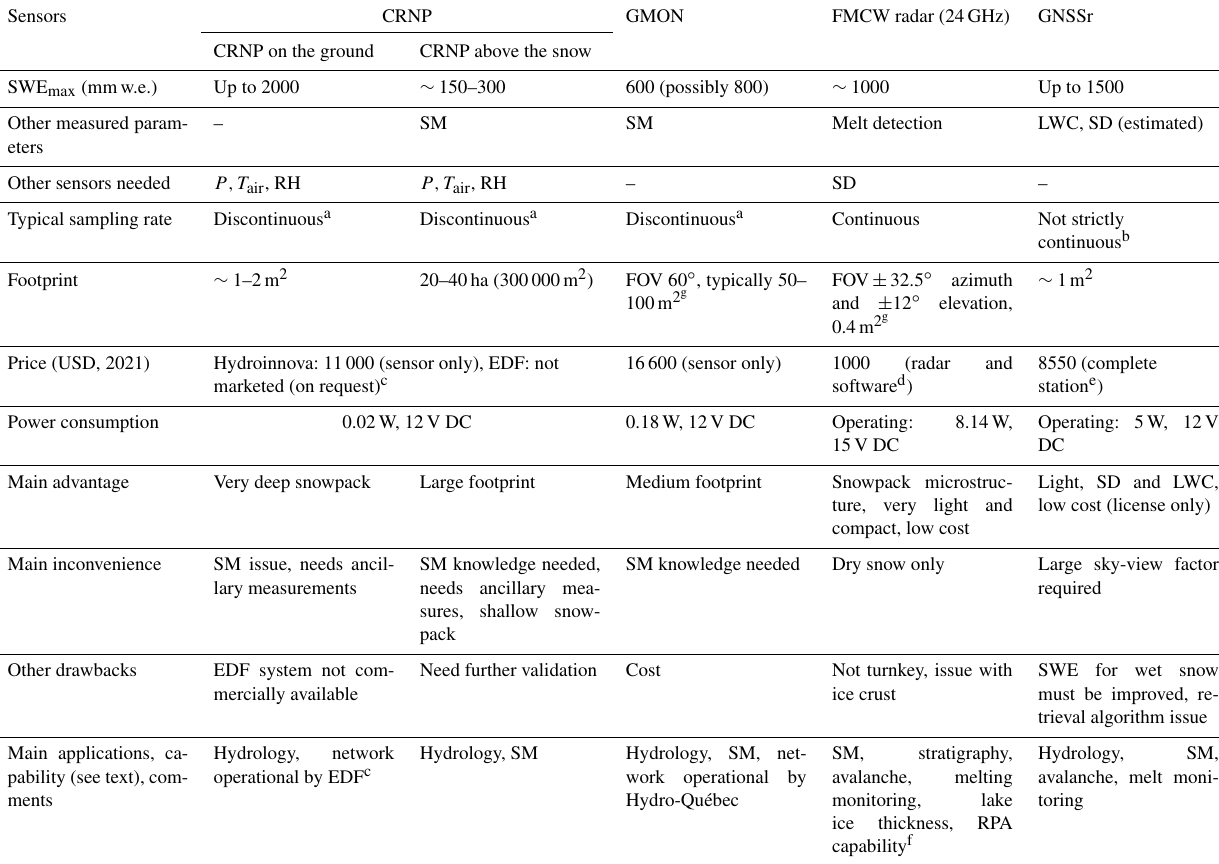
Table 3. Pros and cons of the four systems that were considered for SWE monitoring. SM: soil moisture. FOV: field of view. LWC: liquid water content. RPA: remotely piloted aircraft. The approximate price is given (2021) but is subject to change according to exchange rate